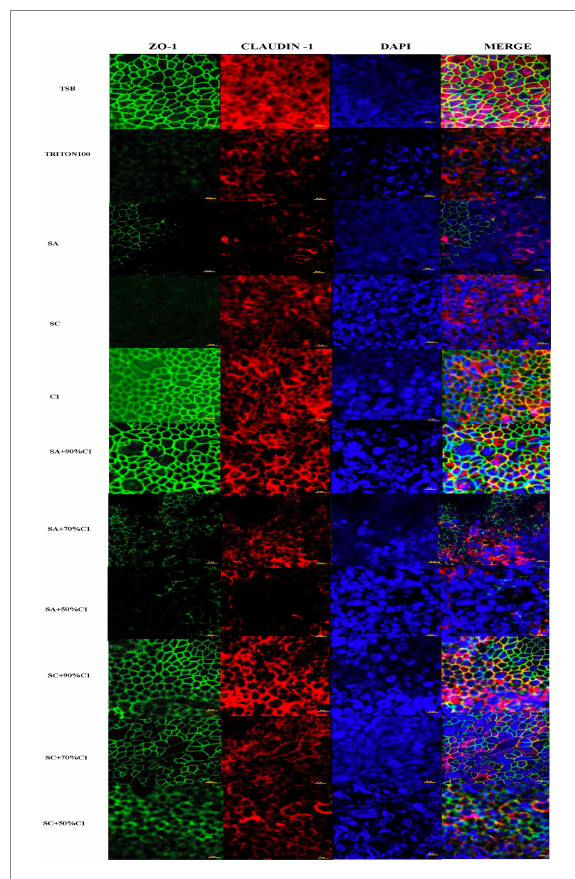
FIGURE 4 Corynebacterium accolens cell-free culture supernatants reduce S. aureus cell-free culture supernatants-induced detrimental effects on HNEC-ALI cultures tight junctions. Immunofluorescence staining of tight junction proteins of HNEC- ALI cultures treated with cell-free culture supernatants from SA and SC co-cultured with C. accolens in different ratios. HNEC- ALI cultured cells were stained with antibodies against Z0- 1(green), claudin-1 (red) and DAPI to resolve nuclei (blue). TSB treatment was used as the negative control. Triton-100 was used as the positive control. Images were examined with confocal laser-scanning microscope (Scale bar=10 μ m). C1, C. accolens clinical isolate 1. SA, S. aureus ATCC51650. SC, S. aureus clinical